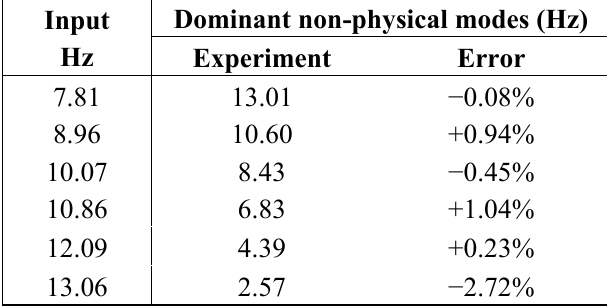
Table 4. Frequency Comparison of the Dominant Non-Physical Mode, Using Webcam to Capture Vibration Exciter